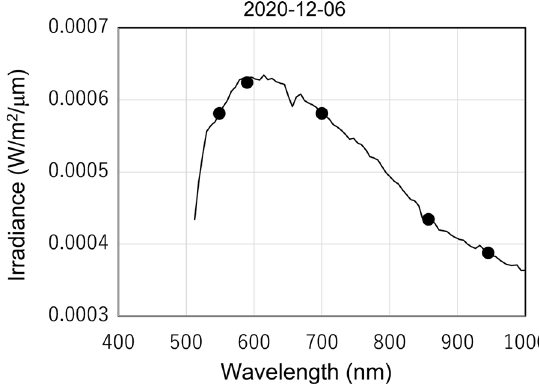
Fig. 10 Observed lunar irradiance taken at 2020-12-06 08:05 (dots) and the modeled spectrum (solid